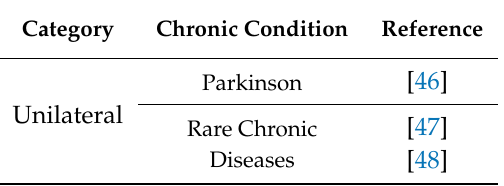
Table 6. Unilateral category chosen